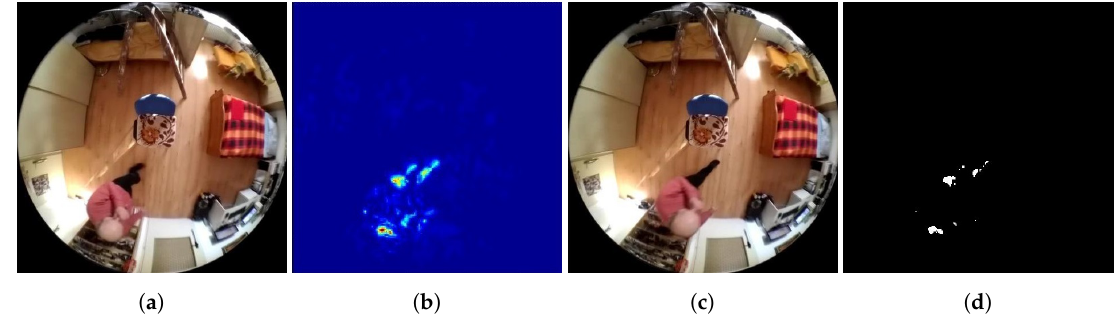
Figure 18. Examples of Method 3. functionality. ( a ) Background frame. ( b ) Map showing the velocity vector magnitude between the frames (dark blue = low velocity, red = high velocity) ( c ) Currently checked frame. ( d ) Binarized map of velocity vector magnitude. Findings that reach a value of logical 1 (white in the frame field) are considered potential findings of a detected